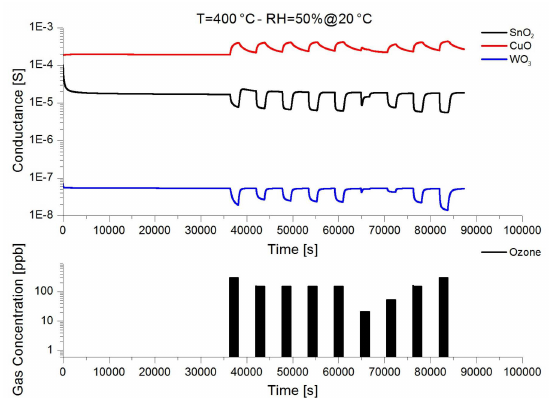
Figure6. DynamicresponseofSnO 2 , CuO,andWO 3 nanowiresinthepresenceofdi ff erentconcentration of ozone (300, 150, 150, 150, 150, 20, 50, 150, 300 ppb, respectively). Operating temperature for all sensing devices was 400 ◦ C. Relative humidity was 50% at 20 ◦